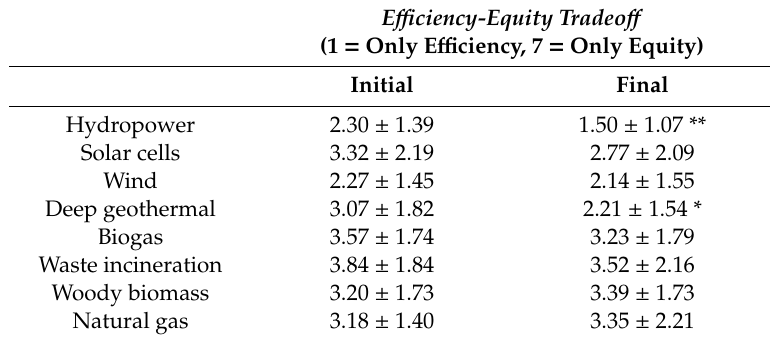
Table 2. Survey results on the initial and final e ffi ciency-equity tradeo ff (means ± standard deviations).